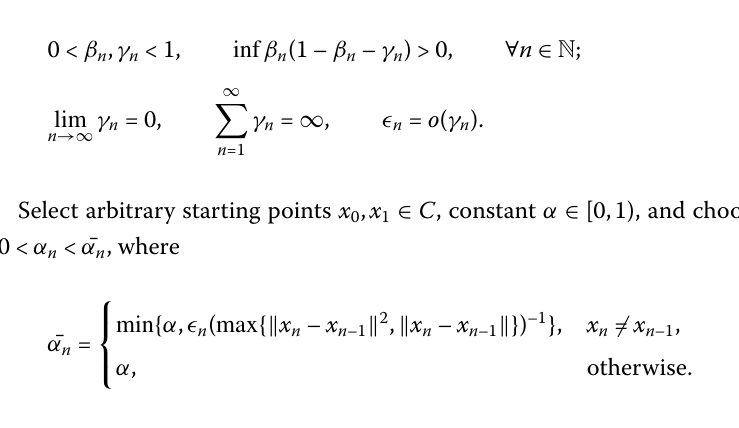
Algorithm 3.2 Choose positive sequences { (cid:14) n } , { ρ n } , { β n } and { γ n } satisfying